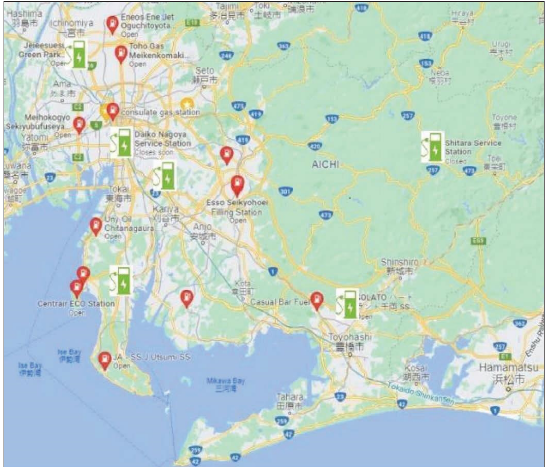
Figure 8: EVCS locations (model M